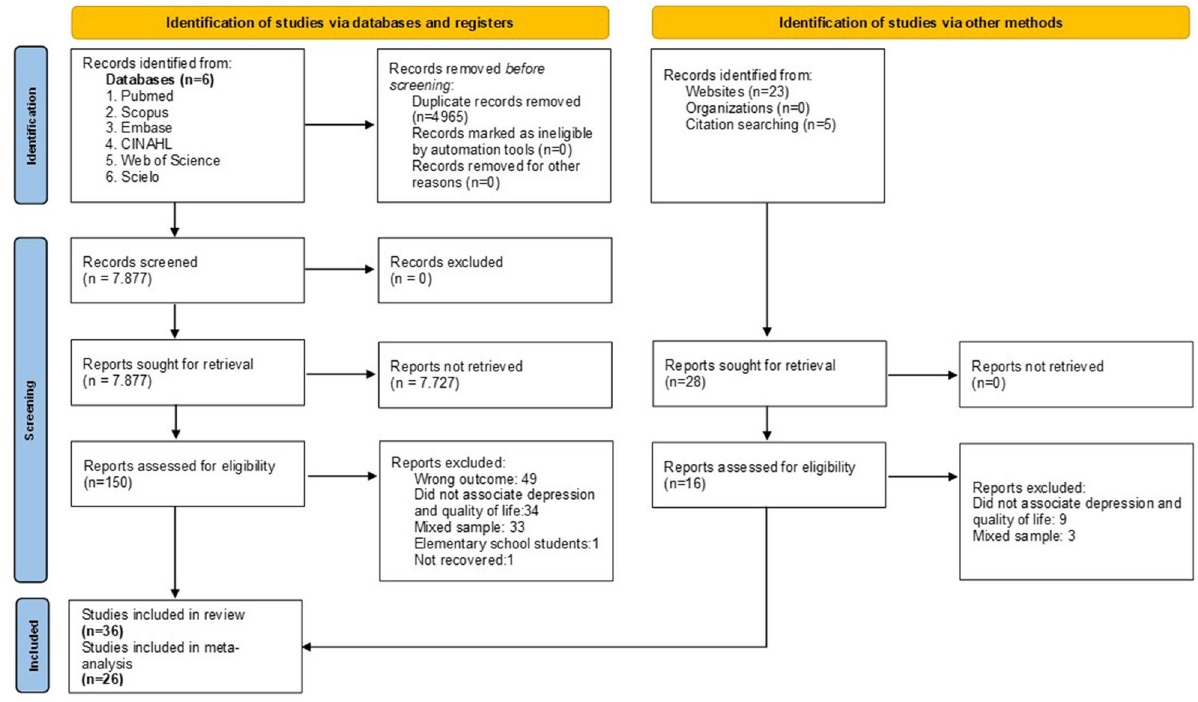
Figure 1. Flow diagram of the selection criteria for the study. Flowchart: Adapted from the PRISMA 2020 Flow